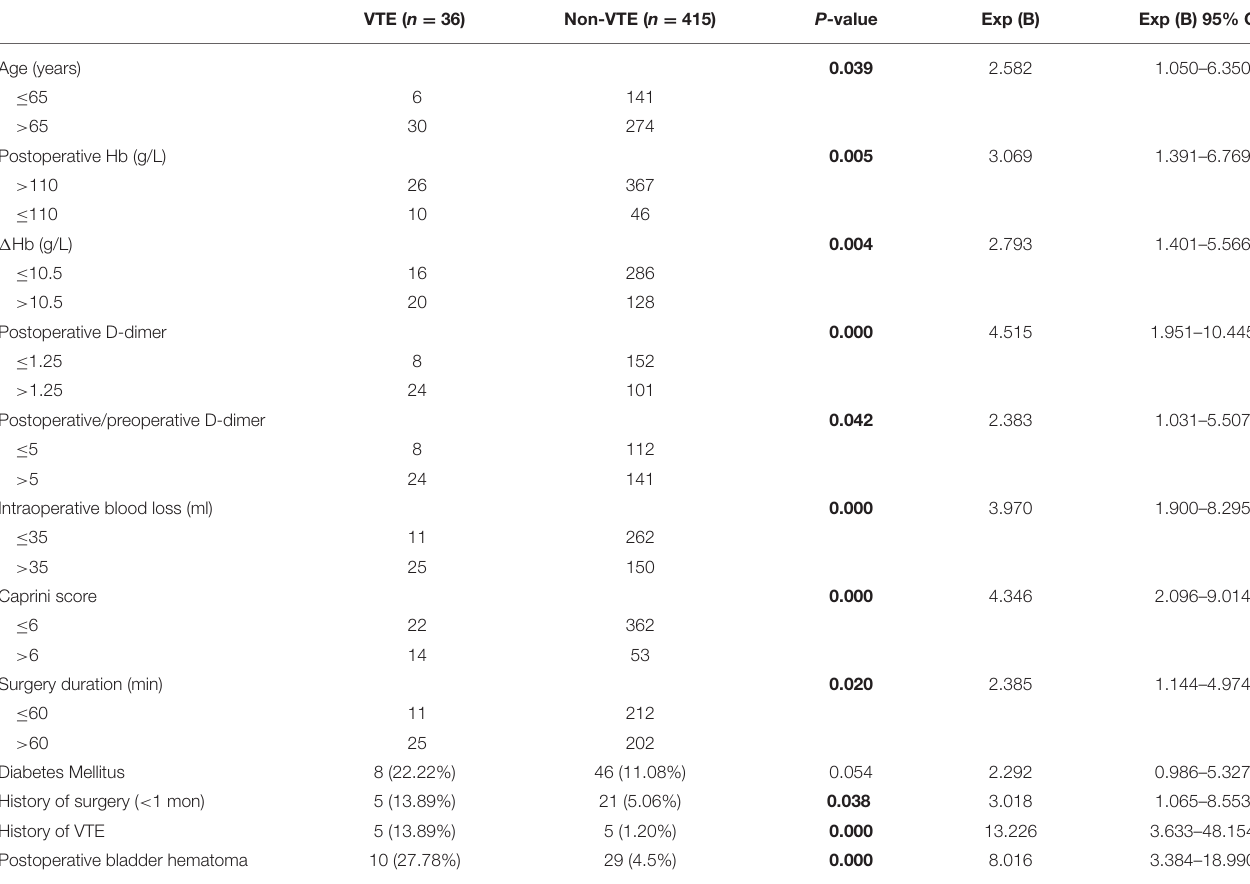
TABLE 2 | Univariate logistic regression analysis of risk factors associated with VTE following